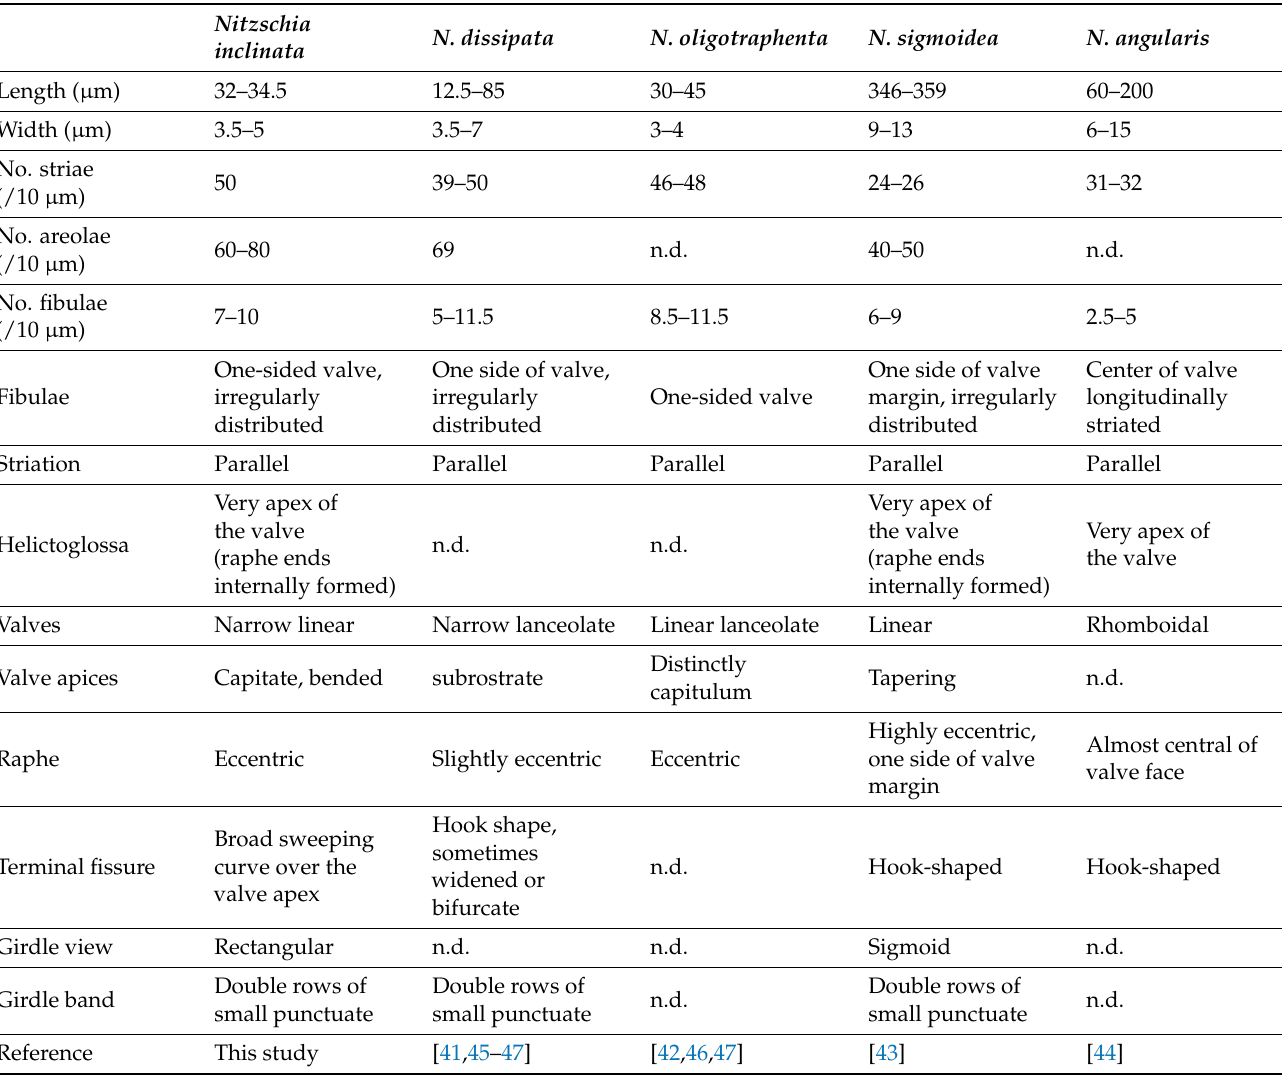
Table 8. Comparison of morphological characteristics for Nitzschia inclinata sp. nov. and closely related